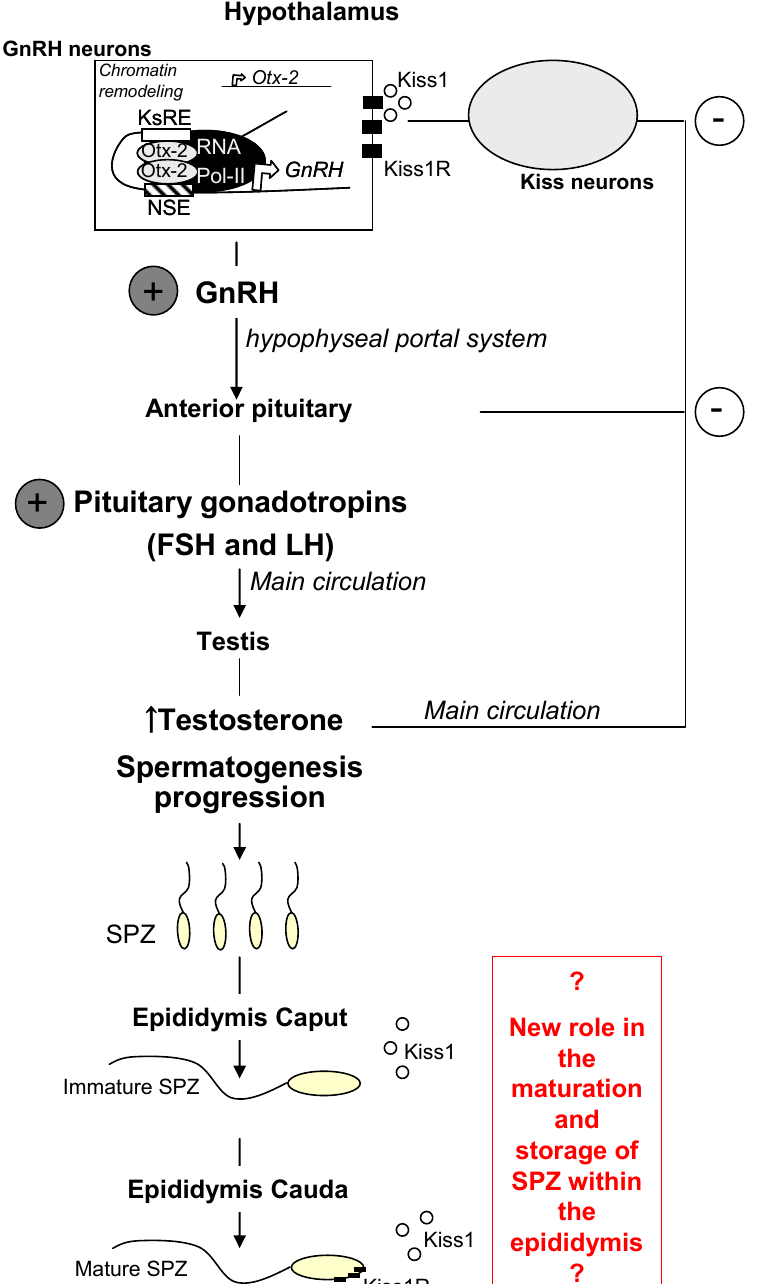
Figure 1. Schematic representation of kisspeptin activity along the hypothalamus–pituitary–testis axis and the shift in Kiss1R localization recently observed in rat and dog SPZ collected in caput and cauda epididymis. See the main text for details. GnRH, Gonadotropin-ReleasingHormone; Kiss1R, kisspeptin receptor; KsRE, kisspeptin-response element; NSE, neuron-specific element; Otx-2, Orthodenticle Homeobox 2; RNA PolII, RNA Polymerase II; SPZ, spermatozoa.